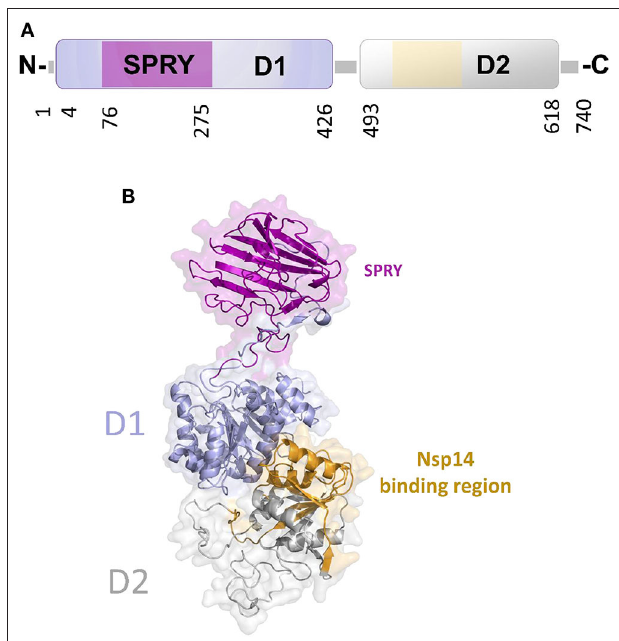
FIGURE 8 | The unique structure of DDX1. (A) Domain organization according to PFAM. (B) Cartoon representation of the homology model of DDX1, computed using Modeler and the structures of DDX Helicase CshA (PDB code 5ivl, coverage 7–75; 276–674, 35% seqid) and of DDX1 SPRY domain (PDB